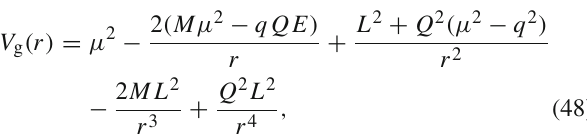
where E = ∂ L /∂ ˙ t is the conserved energy of the particle and V g ( r ) is the geodesic potential defined